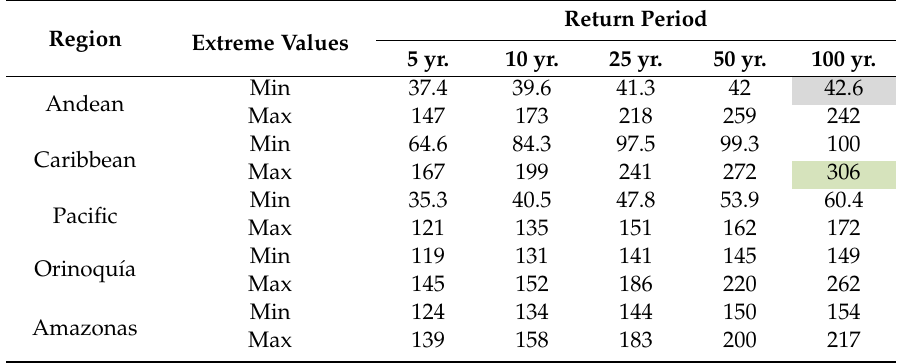
Table 6. Maximum daily precipitation for several return periods using the GEV